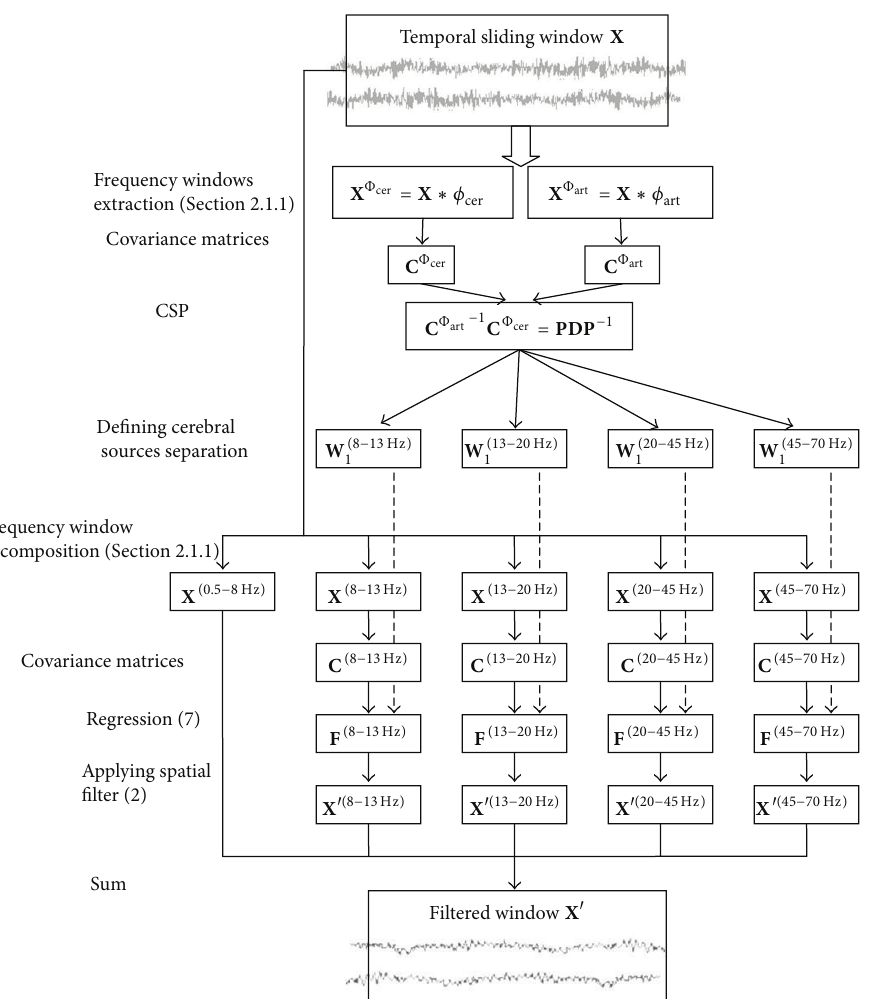
Figure 3: Steps of the DAFOP method to filter muscle